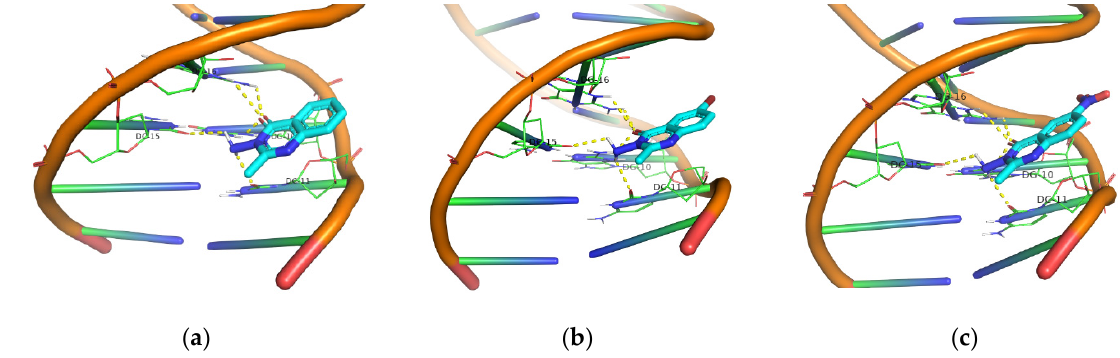
Figure 6. Panel ( a ): Molecular docking Calculations for compound 3c ; Panel ( b ): Molecular docking Calculations for compound 3g ; Panel ( c ): Molecular docking Calculations for compound 3j .